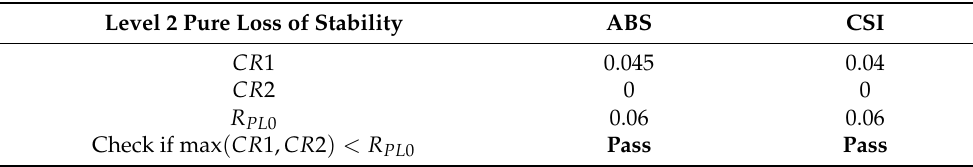
Table 31. Level 2 assessment of the pure Loss of stability failure mode for KCS container